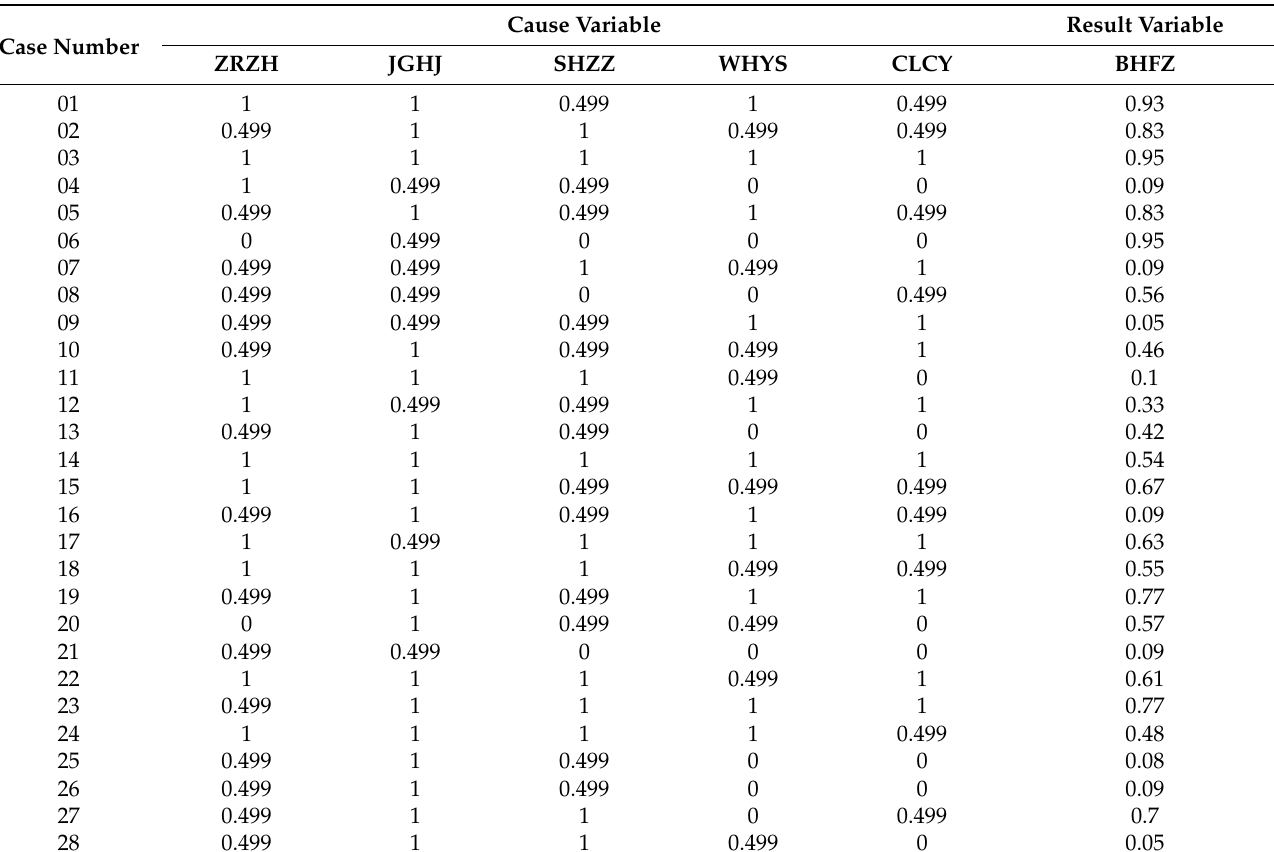
Table 4. Variable